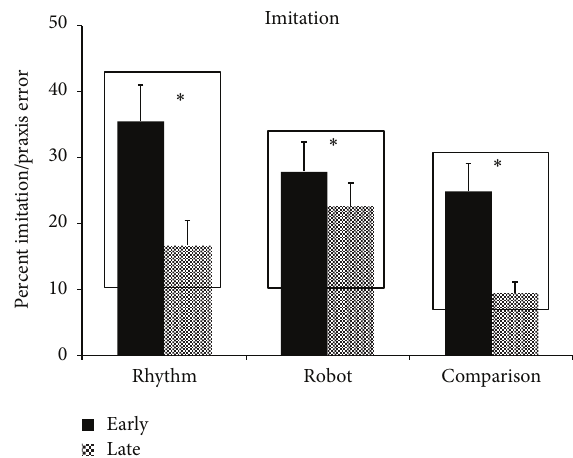
Figure 4: Training-related changes in percent imitation error in the rhythm, robot, and comparison groups. Error bars represent standard errors. ∗ 𝑝 ≤ 0.05 .